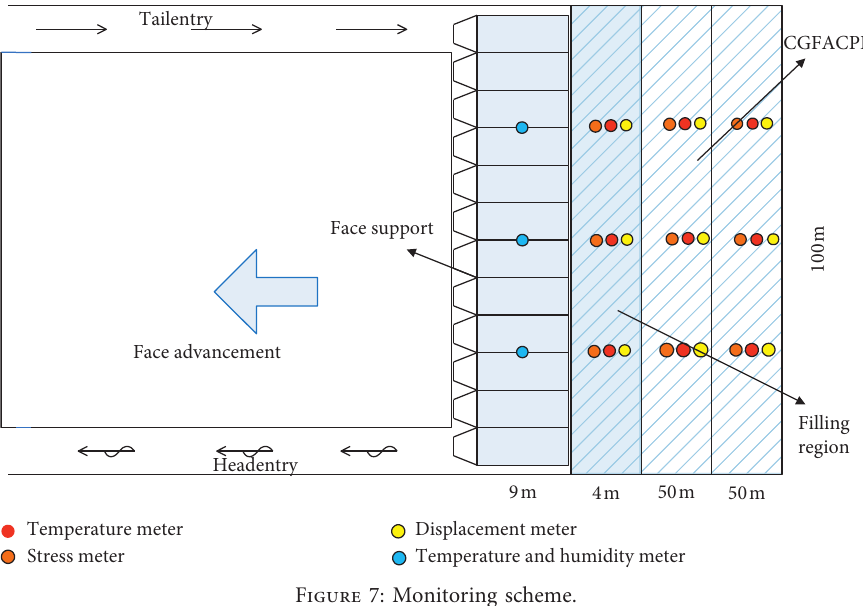
Figure 7: Monitoring scheme.